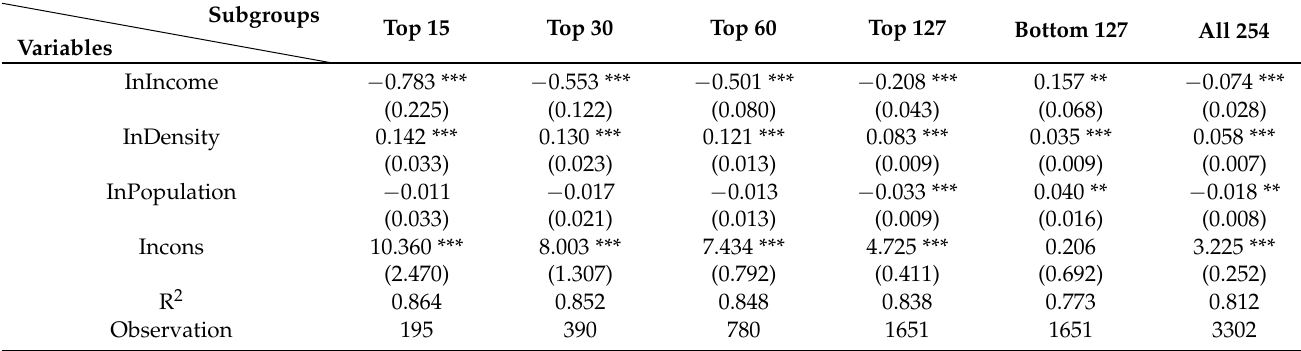
Table 4. Multivariate panel analysis of PM 2.5 concentrations for six income subgroups